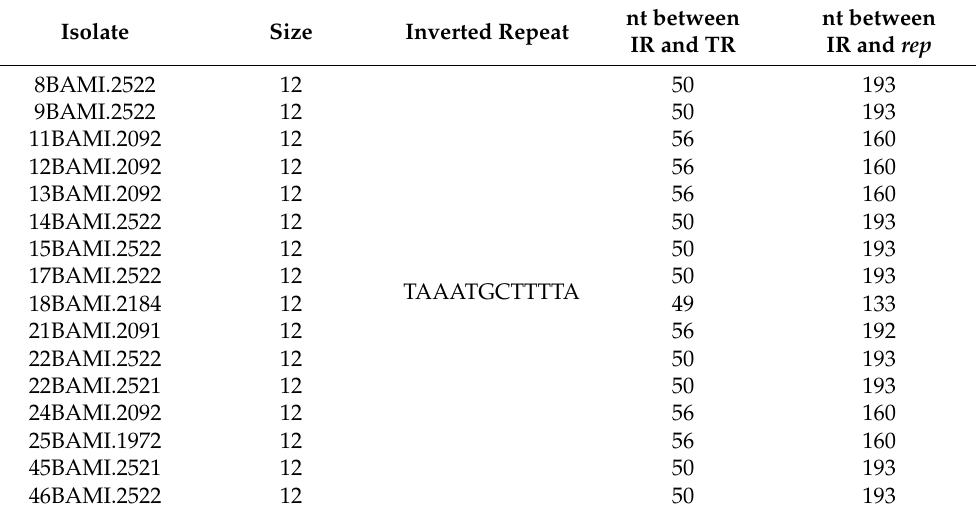
Table 1. Inverted repeat motif as a potential origin of replication. Sequences were detected by EMBOSS inverted repeat finder and additionally compared with the sequences described by zur Hausen et al.